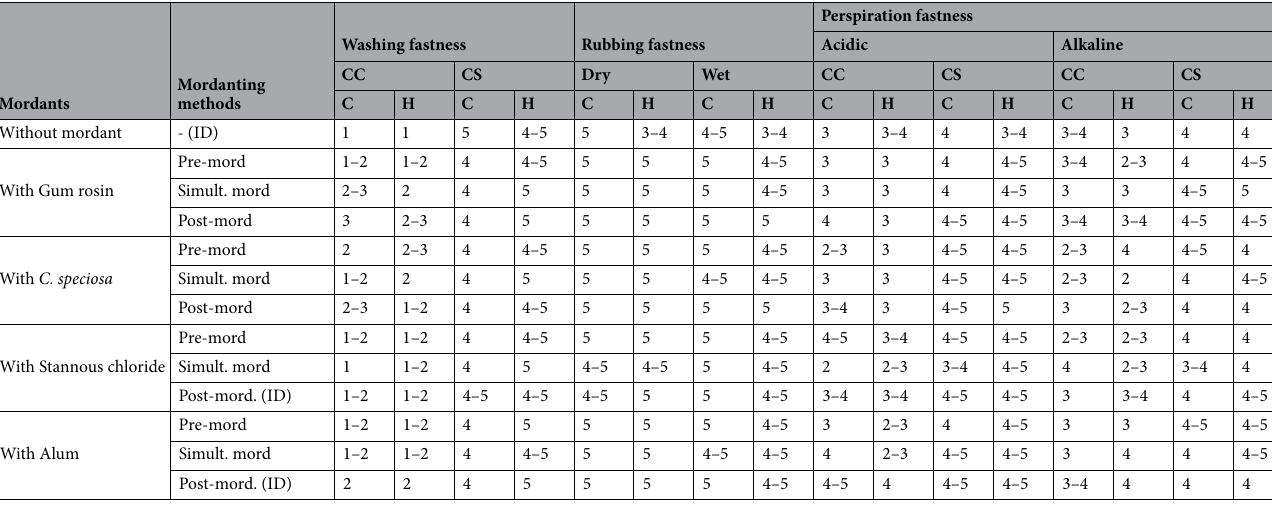
Table 5. Colorfastness of the madder dyed two fabrics. CC, Color change; CS, Color staining; C, Cotton; H, Hemp; ID, Indigenous madder dyeing; Pre-mord, Pre-mordanting; Simult. mord., Simultaneous mordanting; Post-mord, Post mordanting.